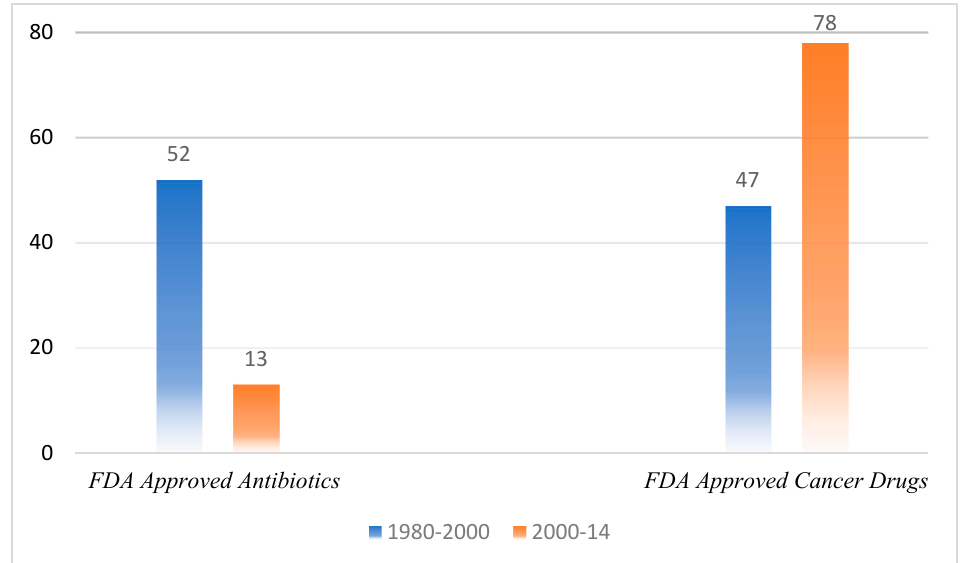
Figure 1. Illustration of FDA-approved drugs (antibiotics vs. anticancer) in the last 40 years.